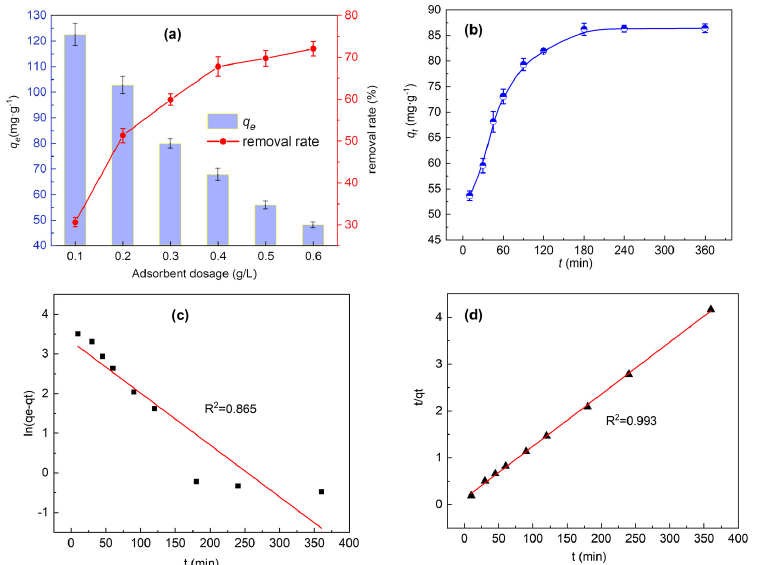
Figure 5. Effect of adsorbent dosage ( a ) and contact times ( b ) for IONPs@MAH- β -CD at pH = 6.0, C 0 = 40 mg L − 1 , 303 K. Pseudo-first-order ( c ) and pseudo-second-order ( d ) kinetic models of U(VI) ad- sorption.